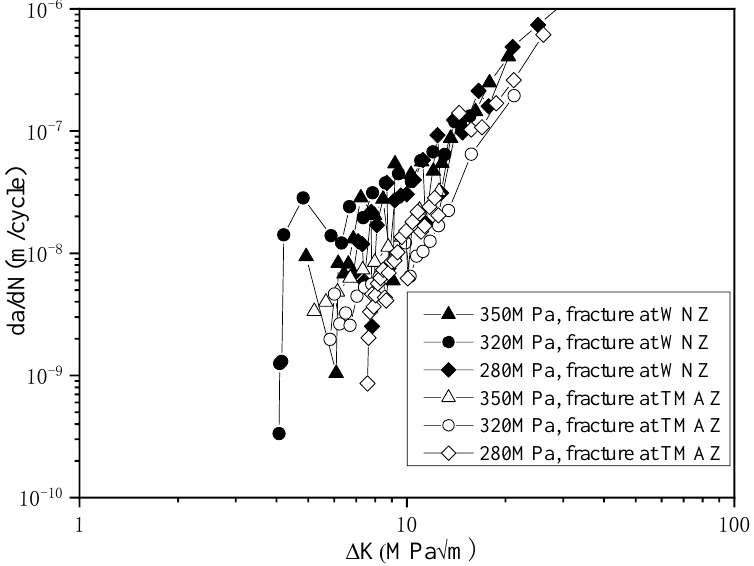
Figure 18. Crack propagation rates in different regions of the FSW joint.